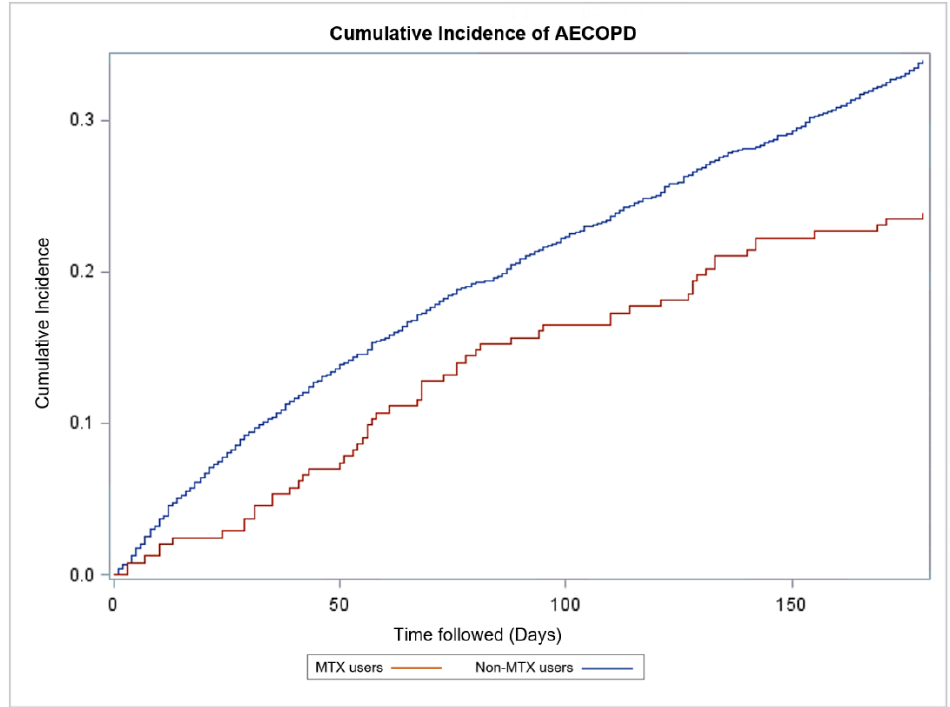
Figure 2. Cumulative incidence of AECOPD in MTX users and non-MTX users in the matched population at 180-day follow-up. MTX was associated with a markedly lower risk of hospitalization-requiring COPD exacerbation within the first half year after study entry (HR 0.66, CI 0.66 – 0.66, p < 0.001). Demographic and clinical characteristics of our study population. Abbreviations: COPD, Chronic Obstructive Pulmonary Disease; AECOPD, Acute hospitalization-requiring exacerbation of COPD; MTX, Methotrexate; HR, Hazard ratio; CI, Confidence interval.